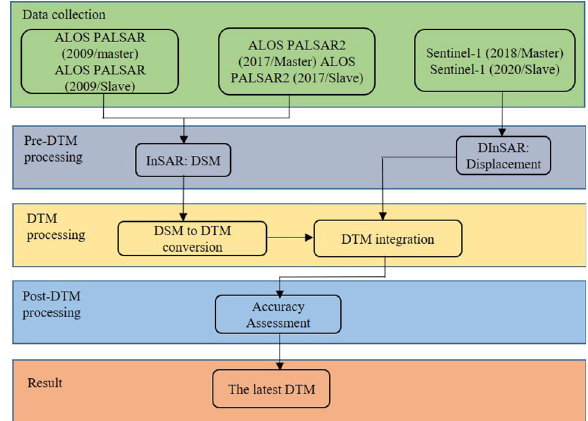
Figure 2. Research